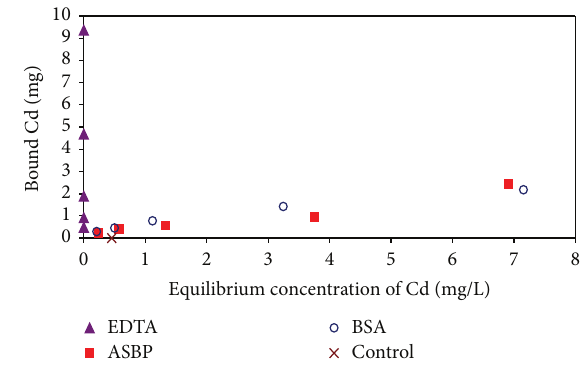
Figure 1: Different Cd-bound forms measured by ISE in 1L solutions at different equilibrium concentrations. EDTA stands for strong chelating agent; BSA stands for protein with metal-binding efficiency; the bound cadmium in the later four concentrations in control series were under detection